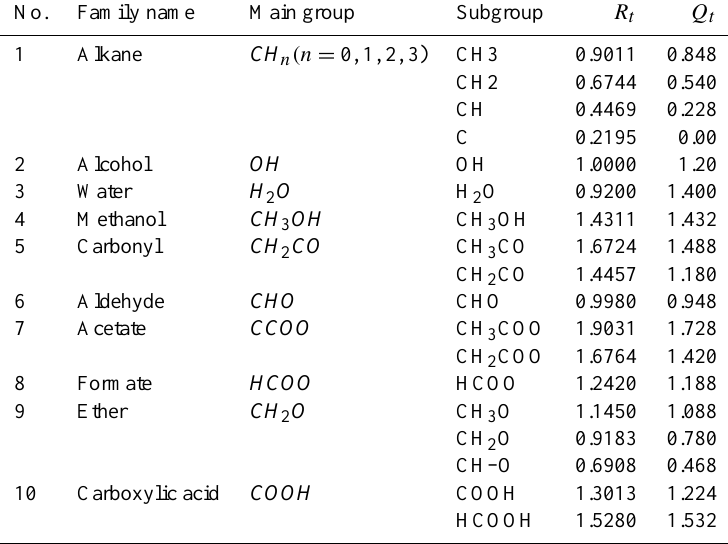
Table A5. UNIFAC relative van der Waals group volume ( R k ) and surface area ( Q k ) parameters for solvent